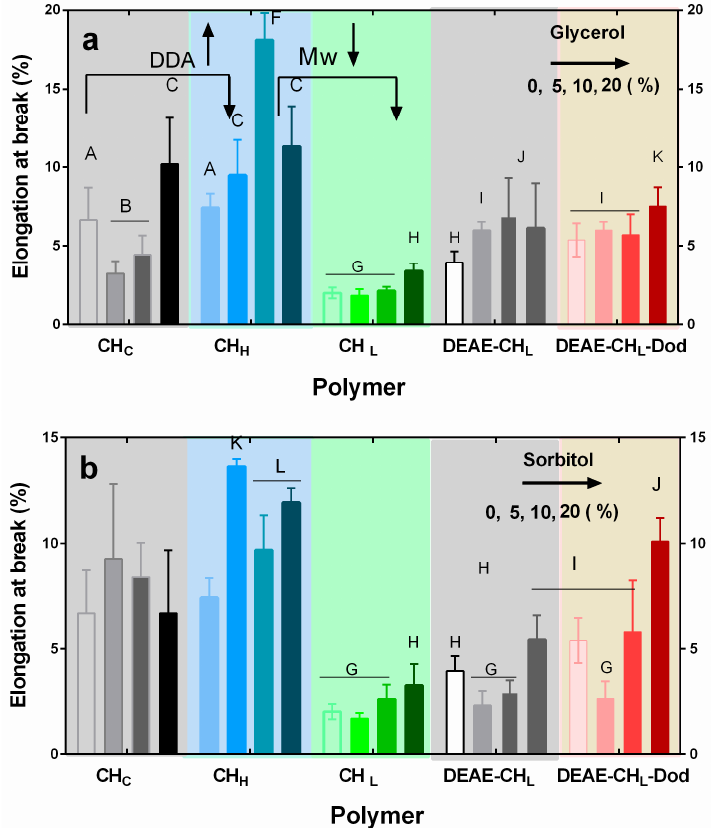
Figure 5. Elongation at break of films prepared with chitosan and its derivatives and increasing percentages of ( a ) glycerol and ( b ) sorbitol. The values are expressed as means ± SD ( n = 5). Different letters indicate a significant difference ( p <0.05).